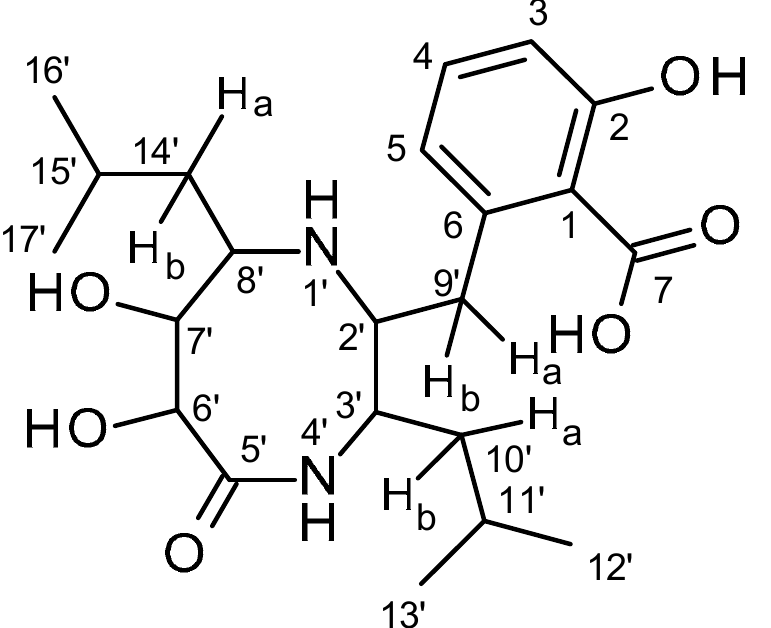
Figure 5. Structure hypothesis of the antimicrobially active substance PP1: 6-[(6,7-dihydroxy-3,8- diisobutyl-5-oxo-1,4-diazocan-2-yl)methyl]-2-hydroxy-benzoic acid. 3.6. Agar Diffusion Tests of Fractionated Culture Supernatants of P. apiarius SBUG 1947